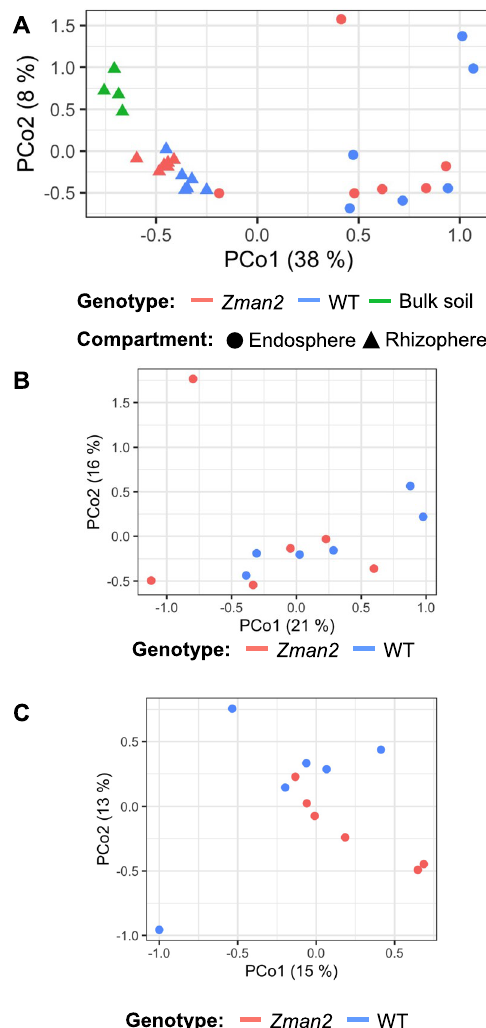
Figure 4. Principal Coordinate Analysis (PCoA) using Bray distances for ( A ) all samples, ( B ) endosphere only, and ( C ) the rhizosphere only. Each point represents an individual plant or soil sample. Percentage in the axis labels represents the eigenvalue, or percent of variation explained by that axis. n = 5 (bulk soil) or n = 6 (all plant